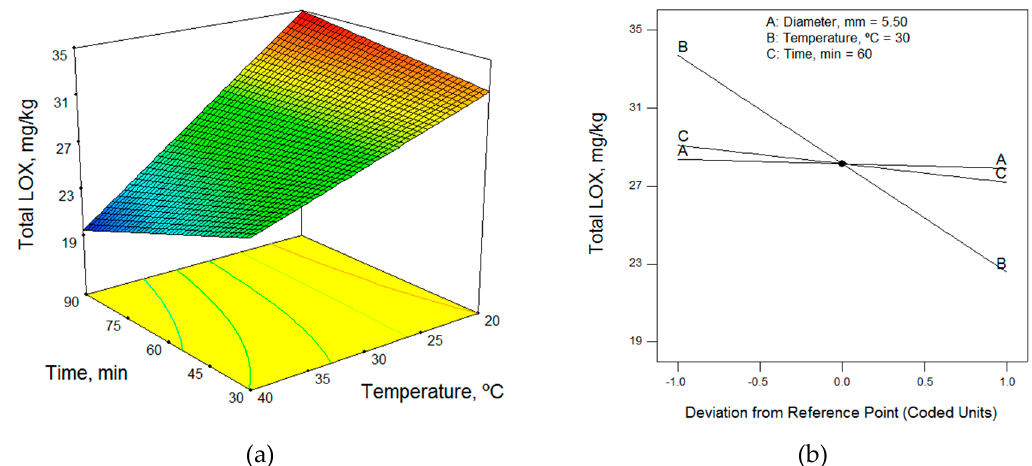
Figure 1. ( a ) Response surface and ( b ) perturbation graphic of the effects of temperature and time on the total LOX volatile content for the Arbequina cultivar (irrigated, MI = 1.11), for a diameter of 5.5 mm.